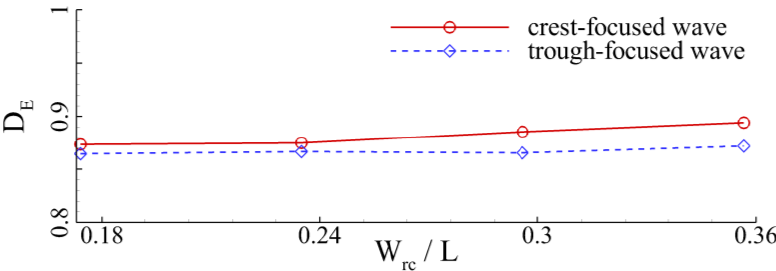
Figure 60. Wave energy dissipation rate versus the ridge width.